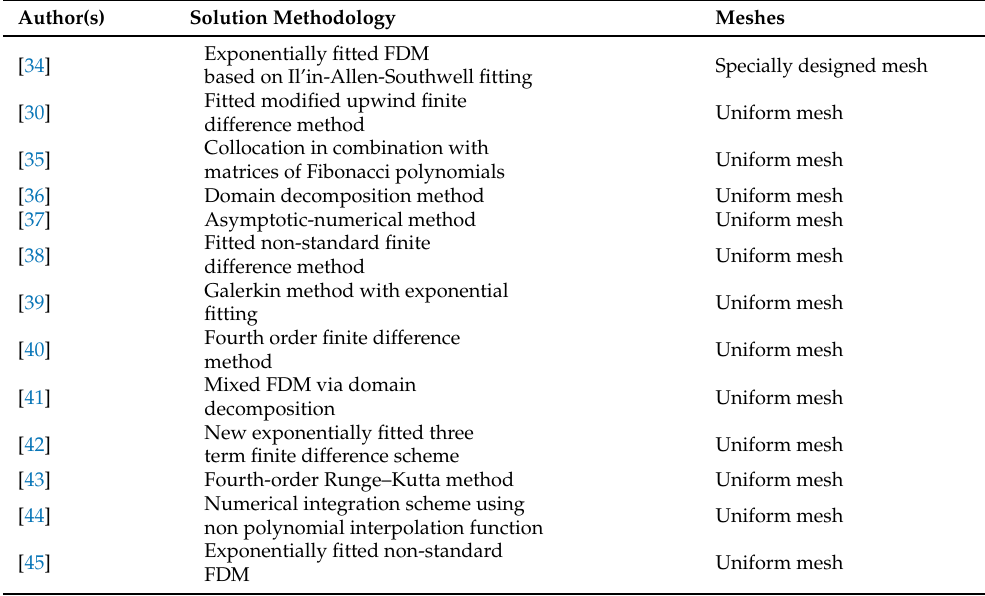
Table 2. Various methods and mesh used to solve Equations (1) and